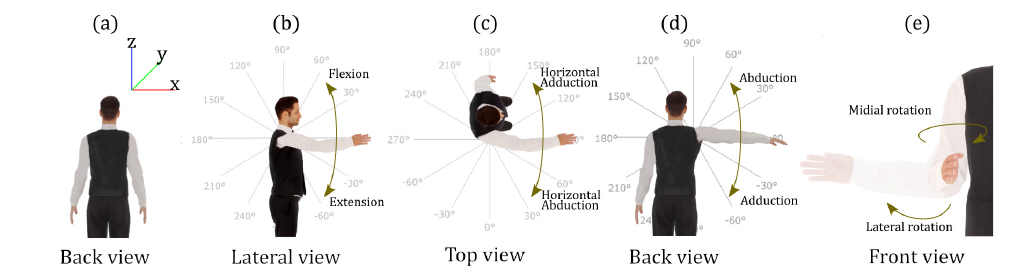
Figure 2. Gestures that define the work space of the right arm. ( a ) Rest position. ( b ) Flexion/extension gesture corresponding to the YZ plane. ( c ) Horizontal abduction/adduction corresponding to the plane XY . ( d ) Abduction/adduction gesture corresponding to the XZ plane. ( e ) Depiction of the rotation of the shoulder, named δ 1 .